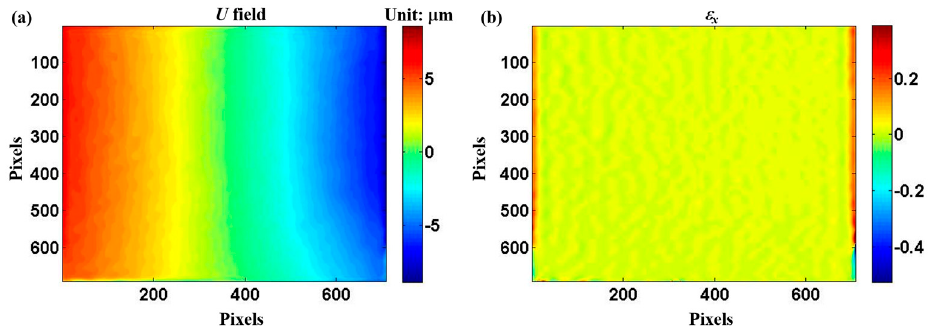
Figure 11. Calculated displacement and strain fields in horizontal direction: ( a ) U and ( b ) ε x . One pixel represents 0.55 µ m. The tensile load is under 52.9 N.